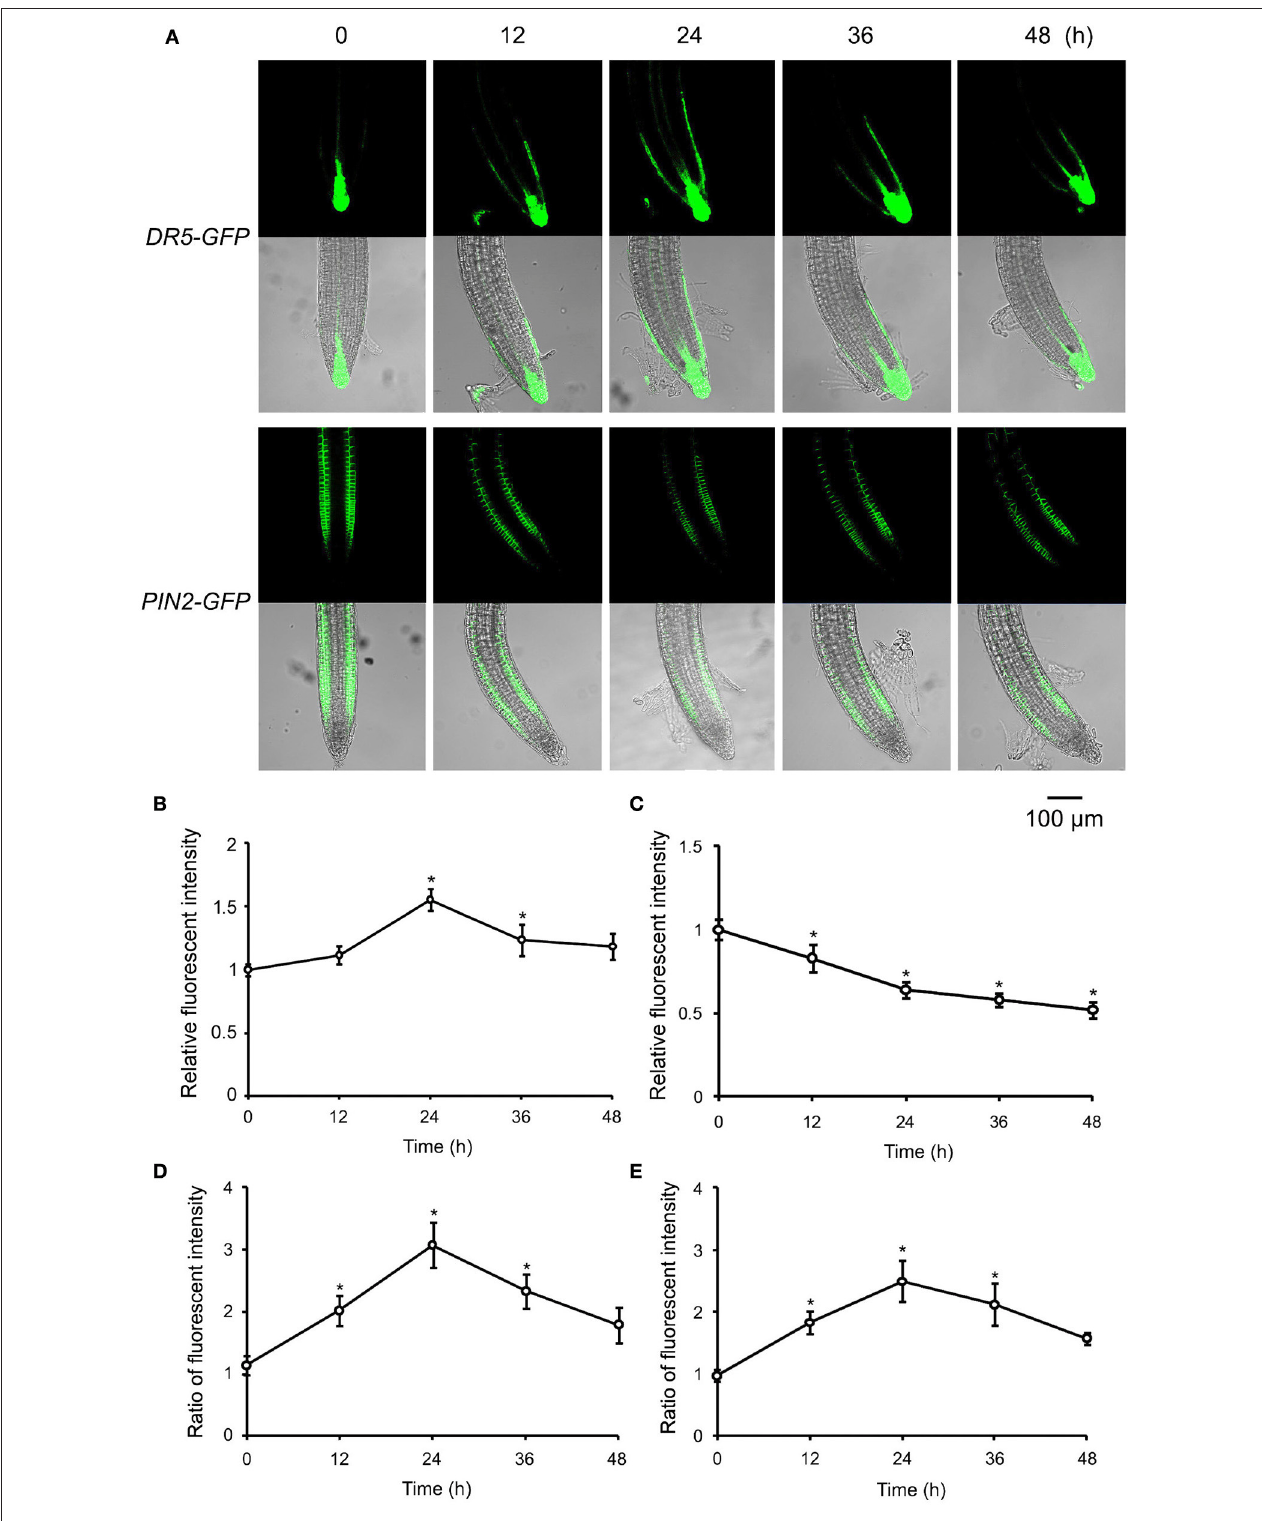
FIGURE 5 | ATP-induced asymmetric distribution of DR5-GFP and PIN2-GFP in root tip cells. DR5-GFP or PIN2-GFP transgenic WS was used as material. Seedlings were grown in 1/2 MS medium for 4 days and transplanted onto 0.5 mM ATP-containing jointed medium. After 12, 24, 36, and 48 h, the fluorescence of DR5-GFP